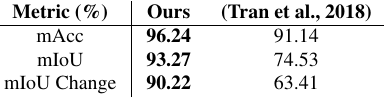
Table 3. Quantitative results (best in bold) of our Siamese KPConv network compared to RF + hand-crafted